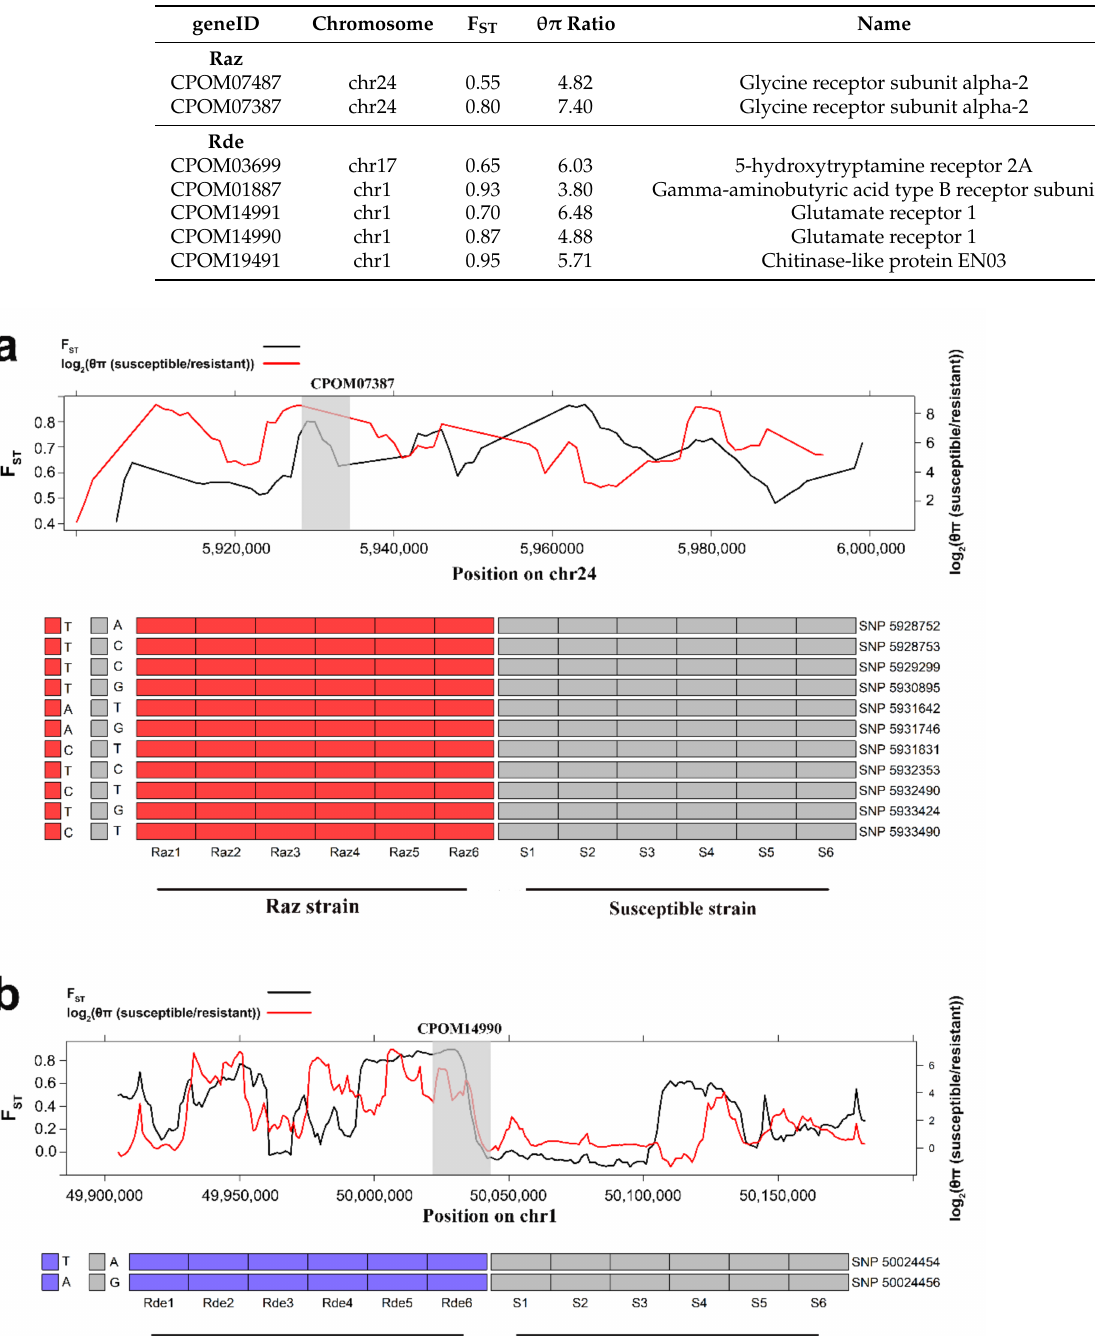
Table 3. Seven PSGs detected with top 5% θπ ratio and top 5% F ST in the Raz and Rde strains, respectively of C. pomonella .